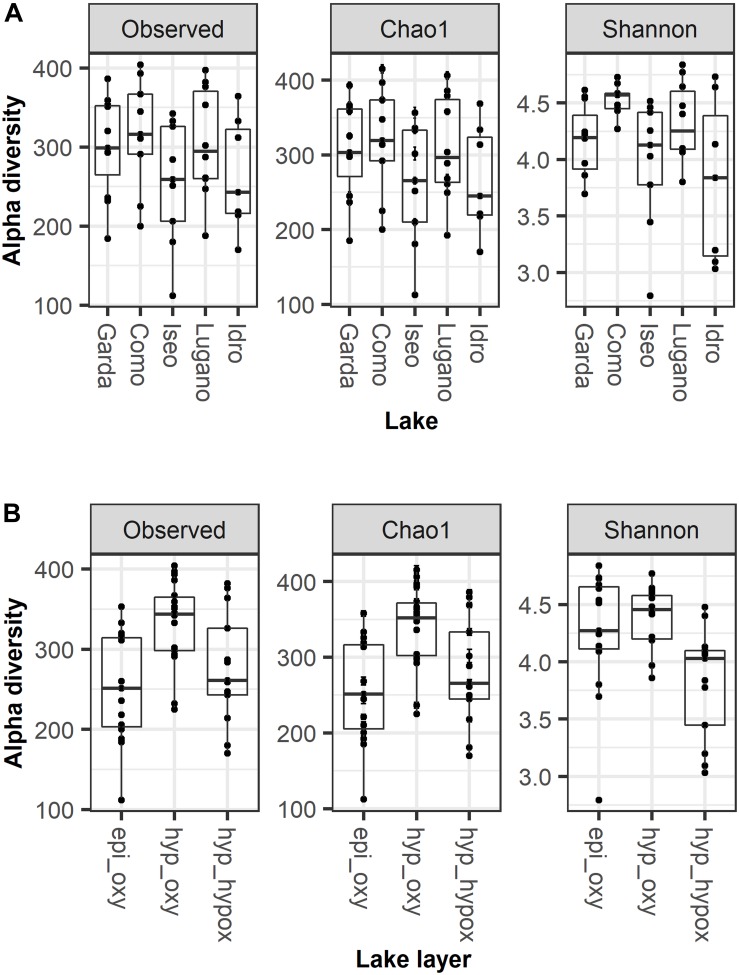
Alpha diversity estimates in (A) the 5 lakes and (B) the three main water layers; epi_oxy, oxygenated upper layers (0–20 m); hyp_oxy, oxygenated hypolimnion; hyp_hypox, hypoxic/anoxic hypolimnion; the three layers are defined as in the text. Boxes report the median and hinges as 25th and 75th quartiles.